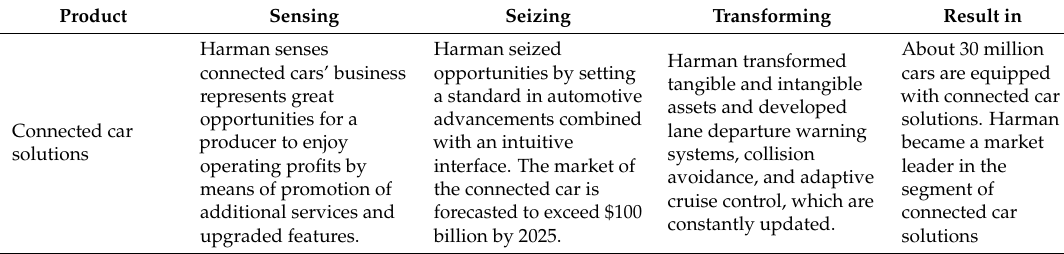
Table 2. Dynamic capabilities at Harman to develop connected car solution before the acquisition by